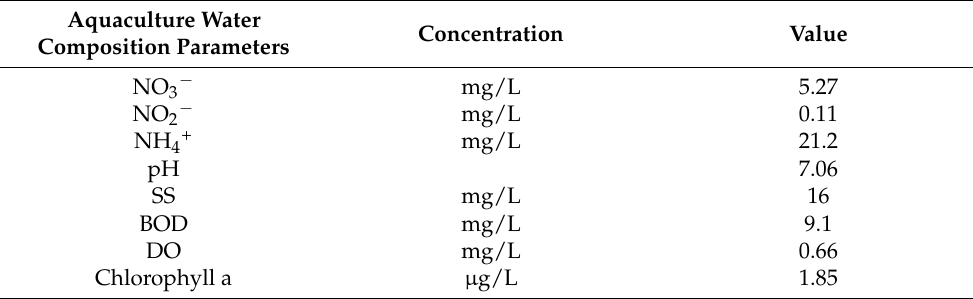
Figure 13. ( a ) Responses of six different NO 3 − -ISM/Co 3 O 4 NPs/SPEs and ( b ) responses of the NO 3 − - ISM/Co 3 O 4 NPs/SPE over fourteen